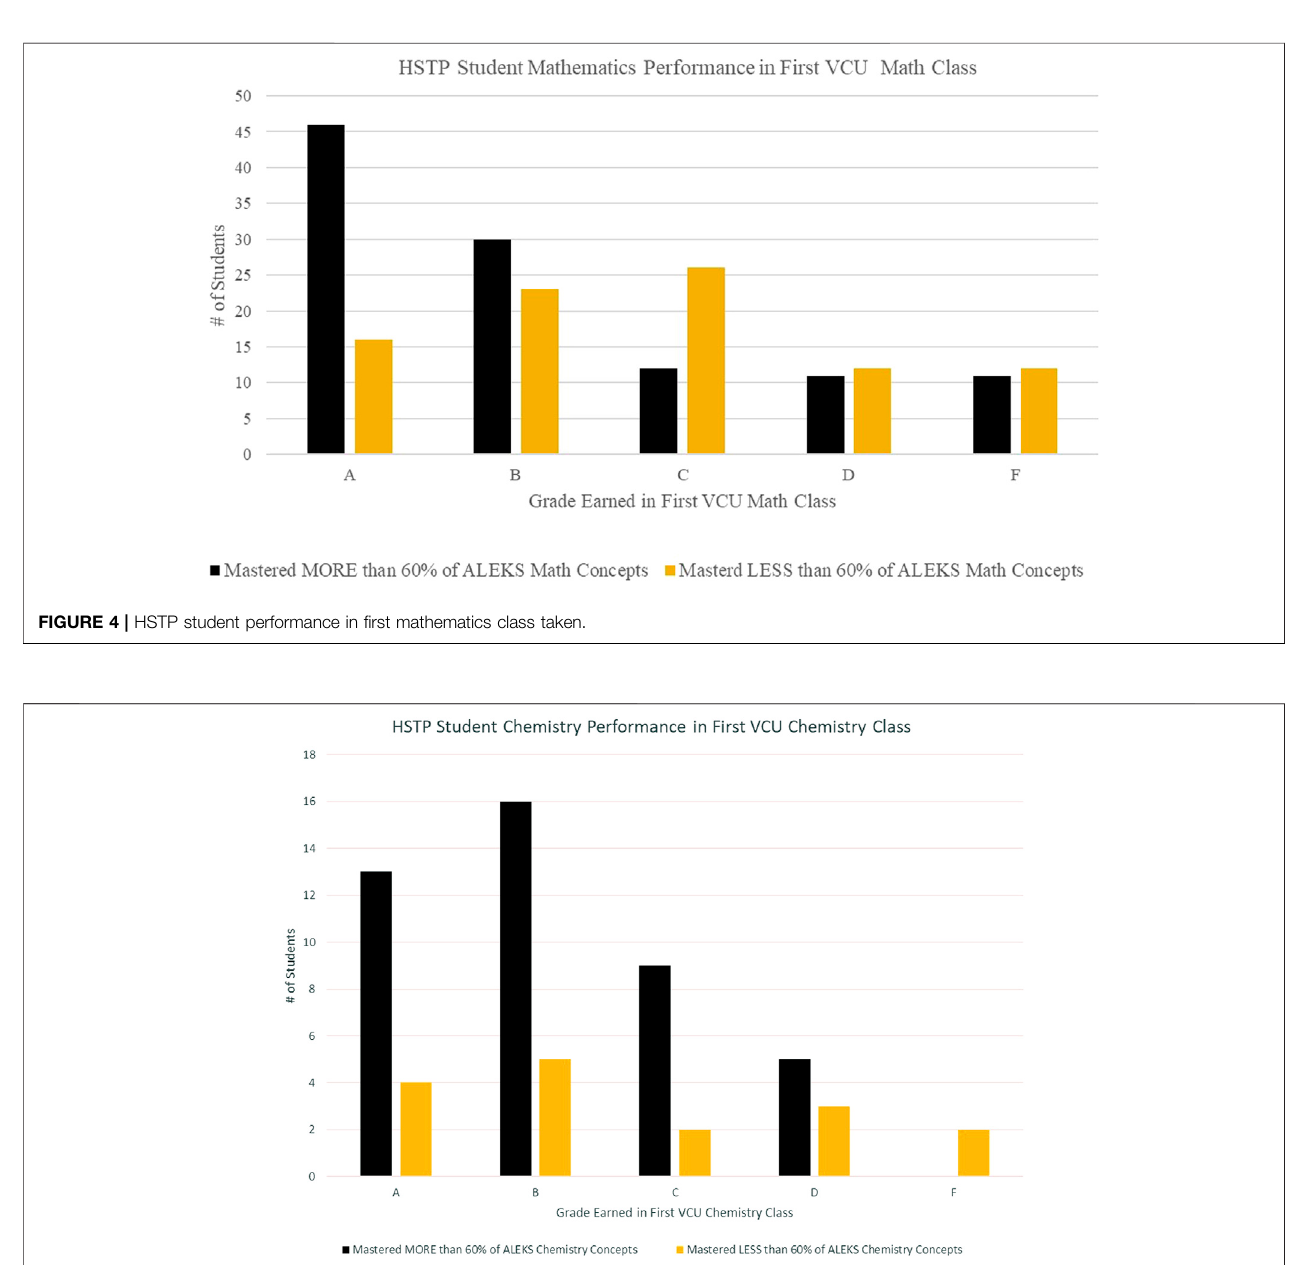
FIGURE 5 | HSTP student performance in General Chemistry